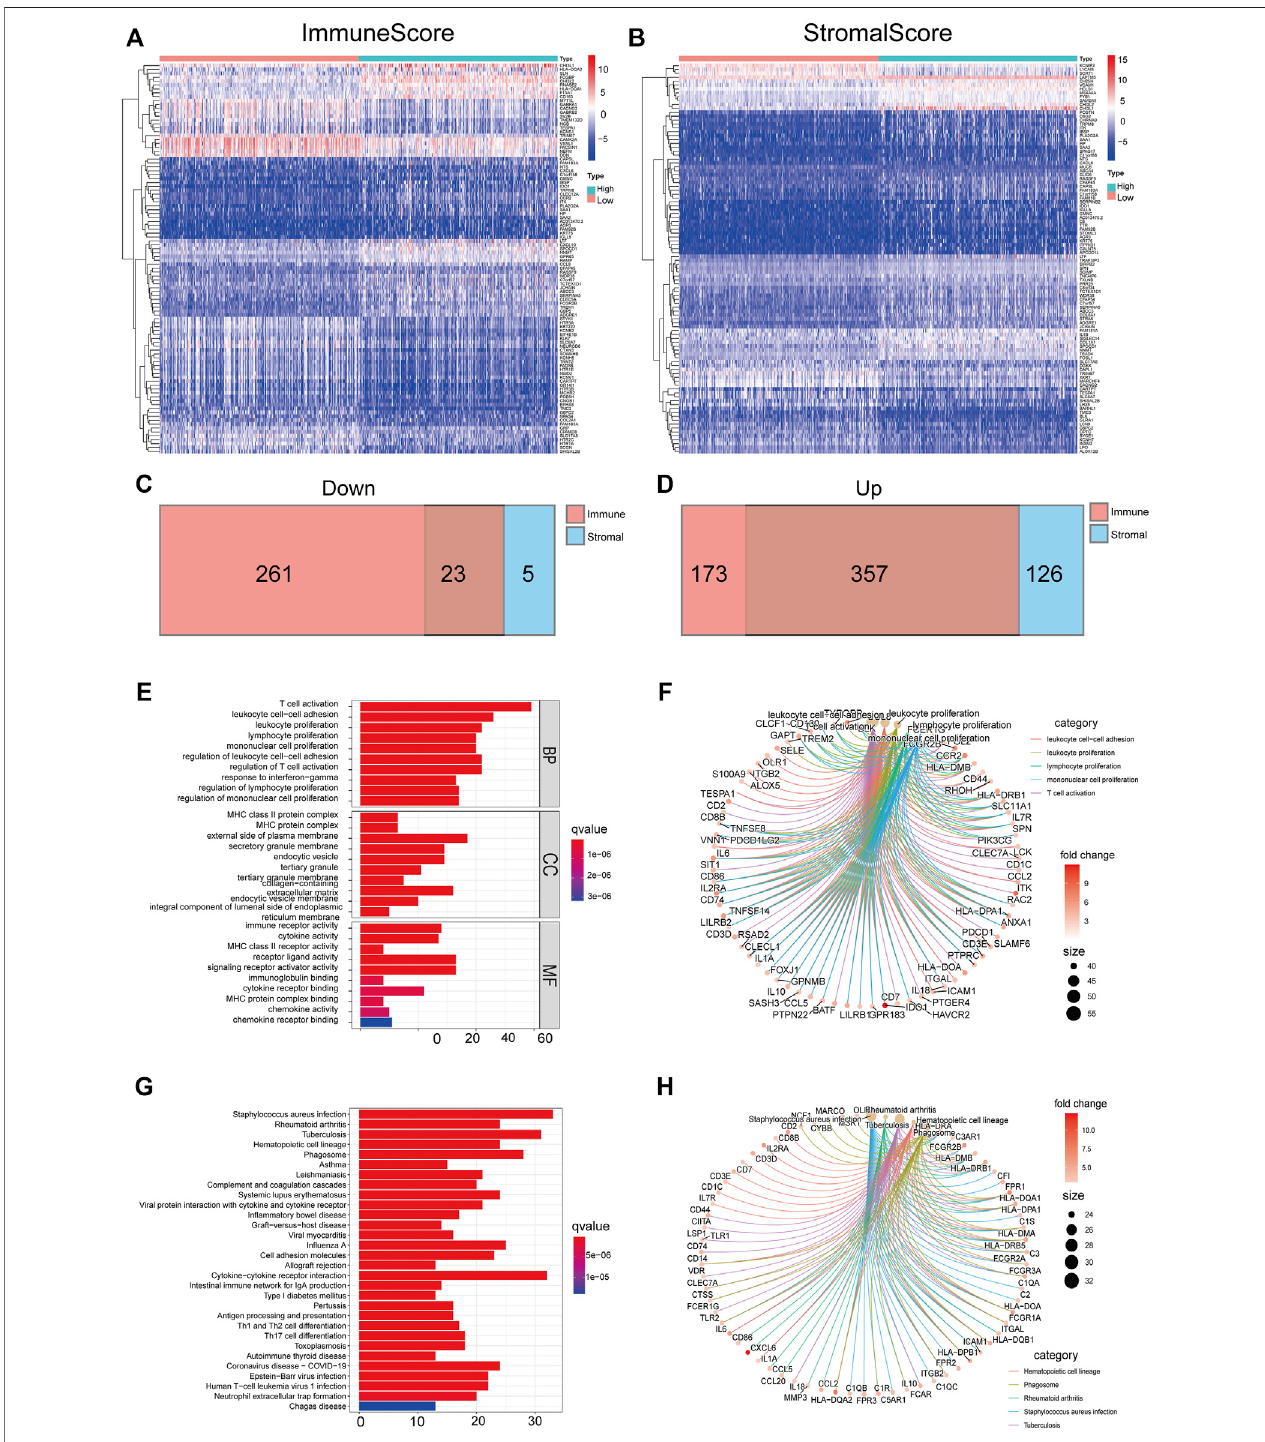
FIGURE 4 | DEGs shared by immune score and stromal score were mainly immune-related genes. The heatmaps of signi fi cant DEGs between high and low immune score (A) or stromal score (B) groups. Venn plots showing common down-regulated (C) and upregulated (D) DEGs sharing immune score and stromal score, red or blue, are immune or stromal DEGs, respectively. GO-enriched functions (E,F) and the KEGG pathway (G,H) analysis of DEGs.